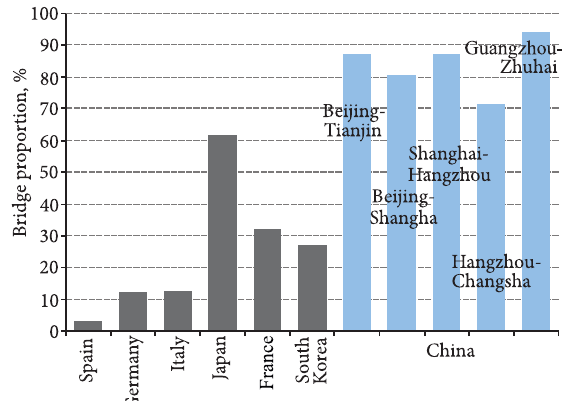
Fig. 1. Percentages of bridges in HSRs